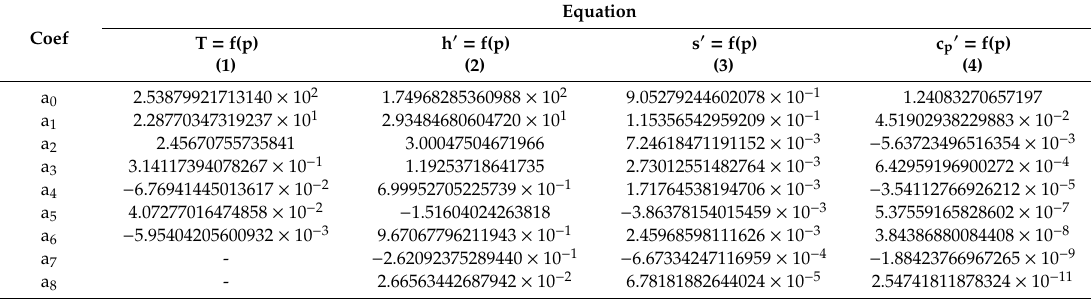
Table 3. Coe ffi cients of polynomials describing the temperature, specific enthalpy, specific entropy, and specific heat of the R1234ze(E) refrigerant in the saturated liquid state.